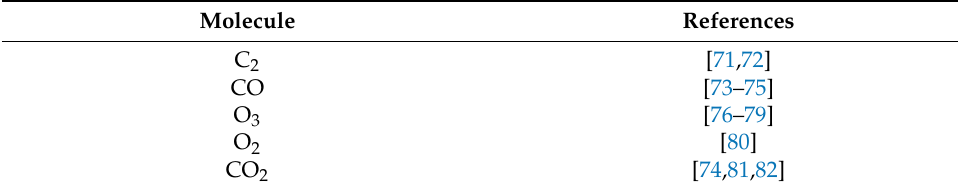
Table 2. References used for photoabsorption cross-sections of major molecular species.